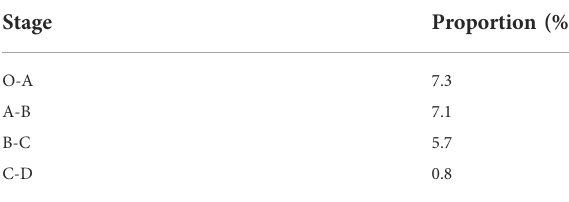
TABLE 5 Times and corresponding cumulative probabilities of the FEs in granite.